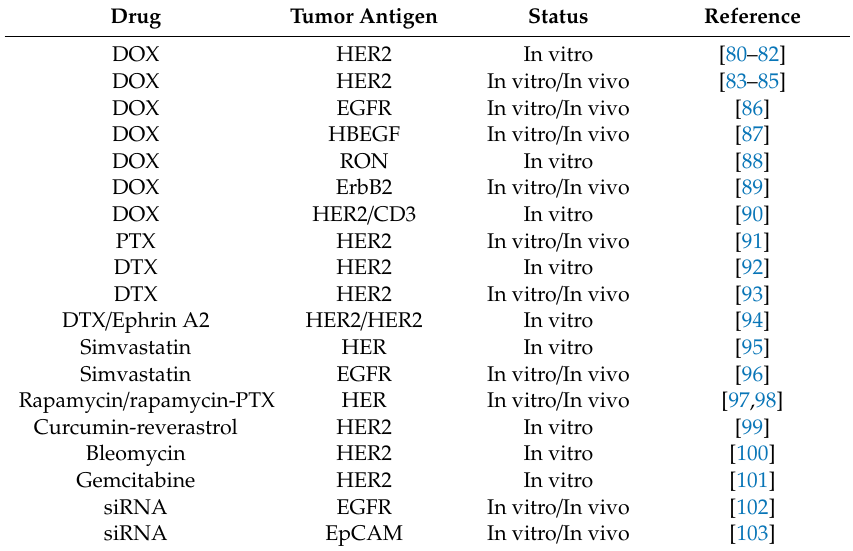
Table 1. Immunoliposomes for breast cancer therapy. DOX: doxorubicin, HER2: human epidermal EGFR: Epidermal Growth Factor Receptor, RON: Recepteur d’Origine Nantais, DTX: Docetaxel, EpCAM:Epithelial Cell Adhesion